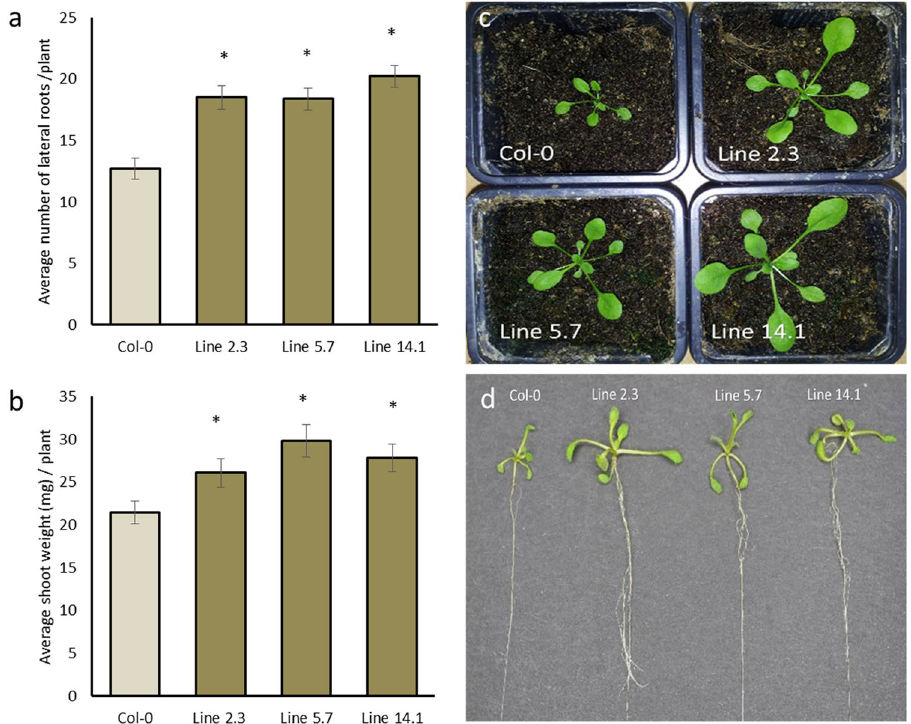
Figure 5. Effect of ectopic expression of Hs-Tyr on Arabidopsis growth. The following parameters were analysed: ( a ) number of lateral roots per plant ( b ) shoot weight and visible increase in the shoot growth. ( c ) and ( d ) comparison of the wild type Col-0 with the overexpression lines. Data are based on three independent experiments. Each bar represents the mean ± standard error of n = 27. Asterisks indicate significant differences based on Student’s t-test ( P <